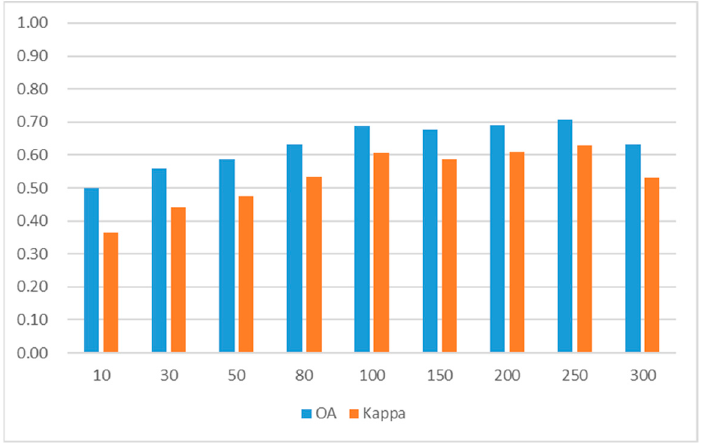
Figure 12. Changes in the accuracy of urban functional region classification under different latent semantic features.